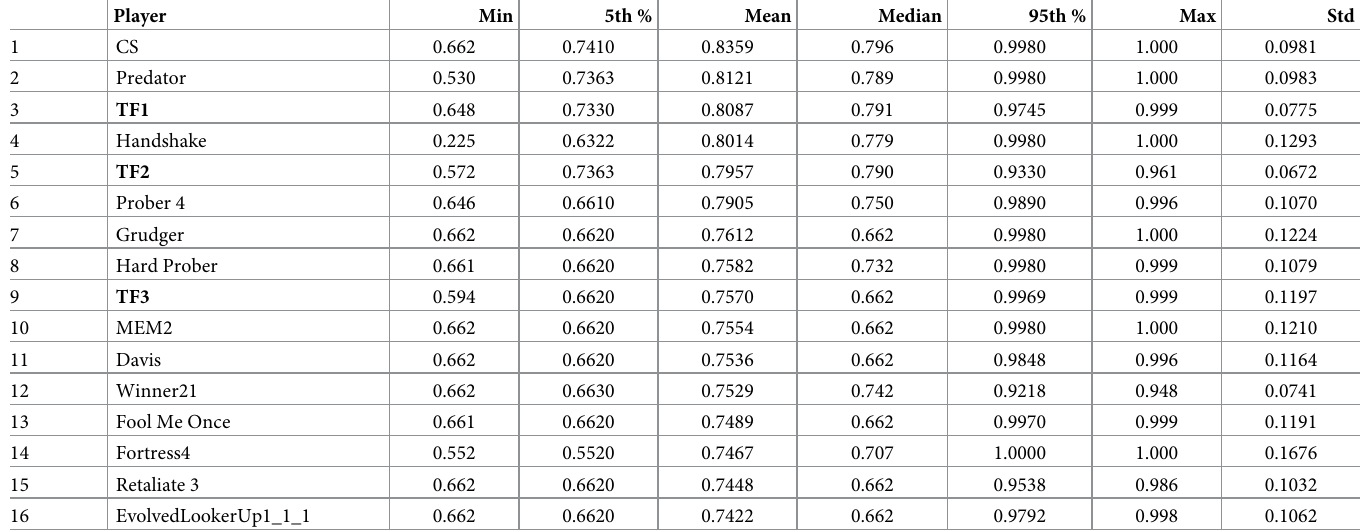
Table 8. Top resistors for N = 3.